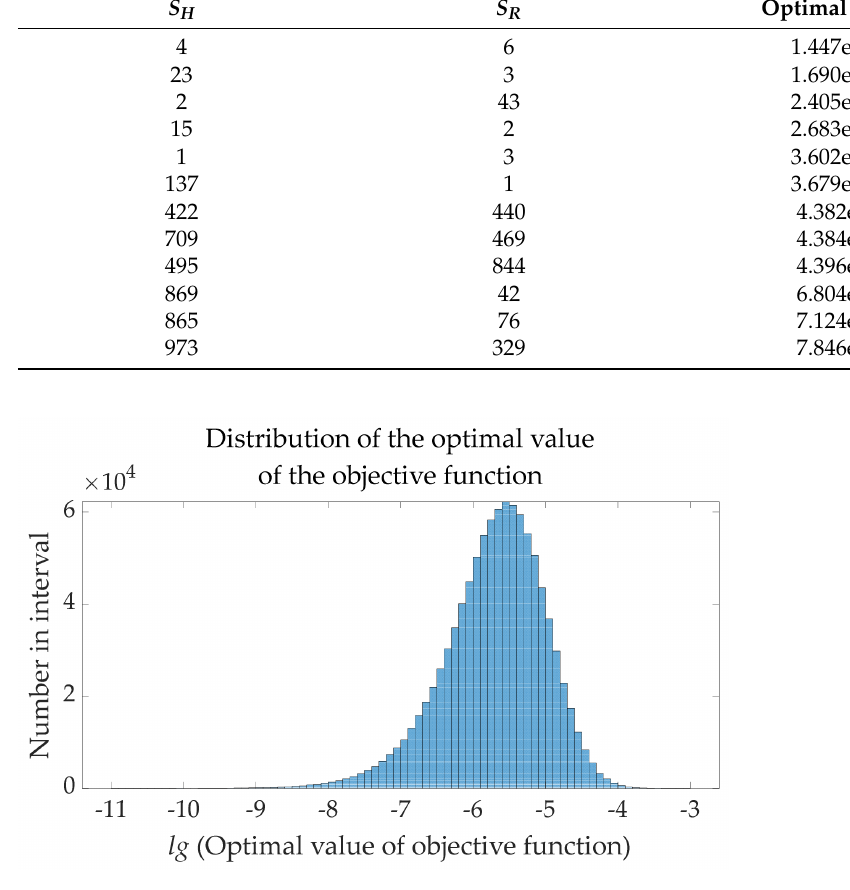
Figure 9. Experiment data set of the optimal value of the objective function calculated by OMO algorithm distribution statistics